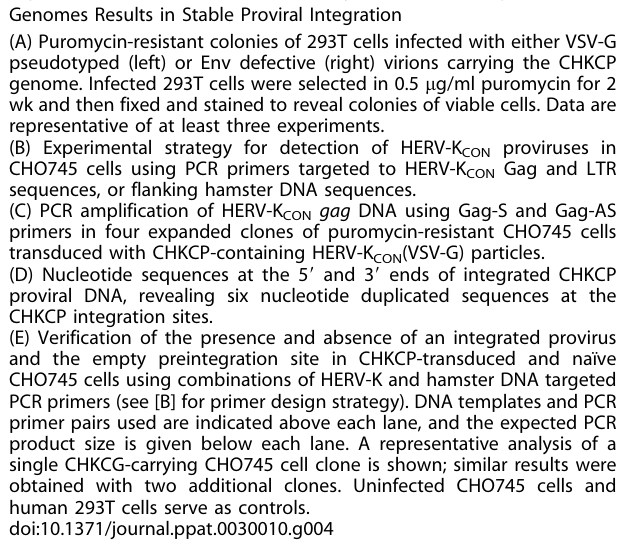
Figure 4. Transduction Mediated by HERV-K CON Gag-PR-Pol and Genomes Results in Stable Proviral Integration (A) Puromycin-resistant colonies of 293T cells infected with either VSV-G pseudotyped (left) or Env defective (right) virions carrying the CHKCP genome. Infected 293T cells were selected in 0.5 l g/ml puromycin for 2 wk and then fixed and stained to reveal colonies of viable cells. Data are representative of at least three experiments. (B) Experimental strategy for detection of HERV-K CON proviruses in CHO745 cells using PCR primers targeted to HERV-K CON Gag and LTR sequences, or flanking hamster DNA sequences. (C) PCR amplification of HERV-K CON gag DNA using Gag-S and Gag-AS primers in four expanded clones of puromycin-resistant CHO745 cells transduced with CHKCP-containing HERV-K CON (VSV-G) particles. (D) Nucleotide sequences at the 5 9 and 3 9 ends of integrated CHKCP proviral DNA, revealing six nucleotide duplicated sequences at the CHKCP integration sites. (E) Verification of the presence and absence of an integrated provirus and the empty preintegration site in CHKCP-transduced and naı¨ve CHO745 cells using combinations of HERV-K and hamster DNA targeted PCR primers (see [B] for primer design strategy). DNA templates and PCR primer pairs used are indicated above each lane, and the expected PCR product size is given below each lane. A representative analysis of a single CHKCG-carrying CHO745 cell clone is shown; similar results were obtained with two additional clones. Uninfected CHO745 cells and human 293T cells serve as controls.